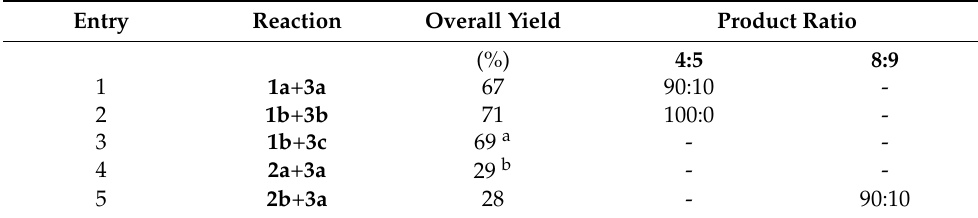
Table 1. Cycloaddition between allenes 1 and 2 and arylazides 3